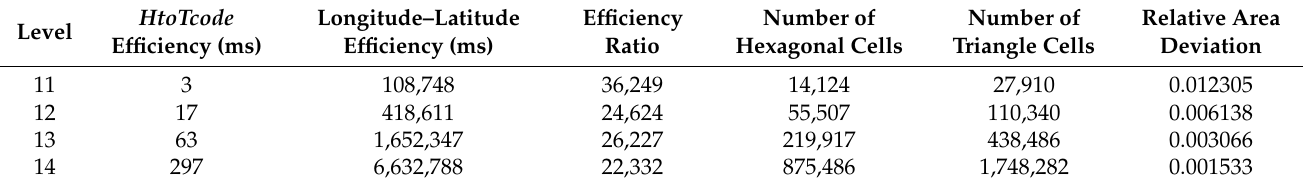
Table 20. Comparison of efficiency and accuracy of HtoTcode and longitude–latitude expressing discrete area.